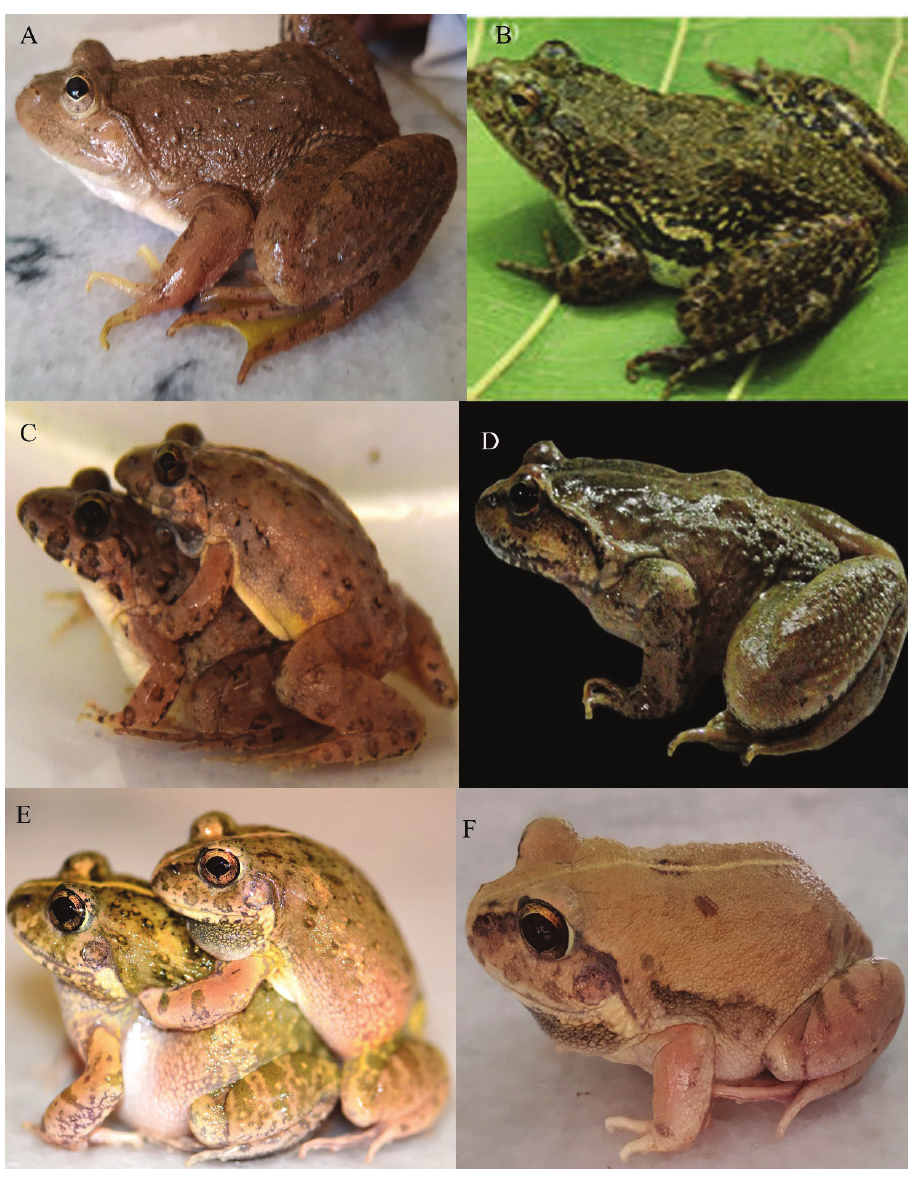
Figure 3. A Skittering Frog ( Euphlyctis cyanophlyctis ) B Skittering Frog ( Euphlyctis kalasgramensis ) C Pierrei’s Cricket Frog ( Minervarya pierrei ) D Murree Hills Frog ( Nanorana vicina ) E , F Burrowing Frog ( Sphaerotheca maskeyi ) . Photographers: Dr Muhammad Rais ( A , C–F ); Waqas Ali ( B ).